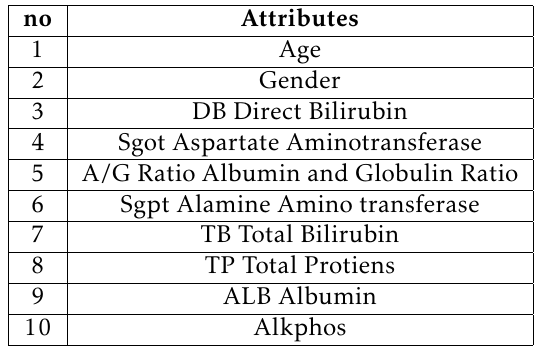
Table 1. The attributes of liver patients in ILPD datasets no Attributes